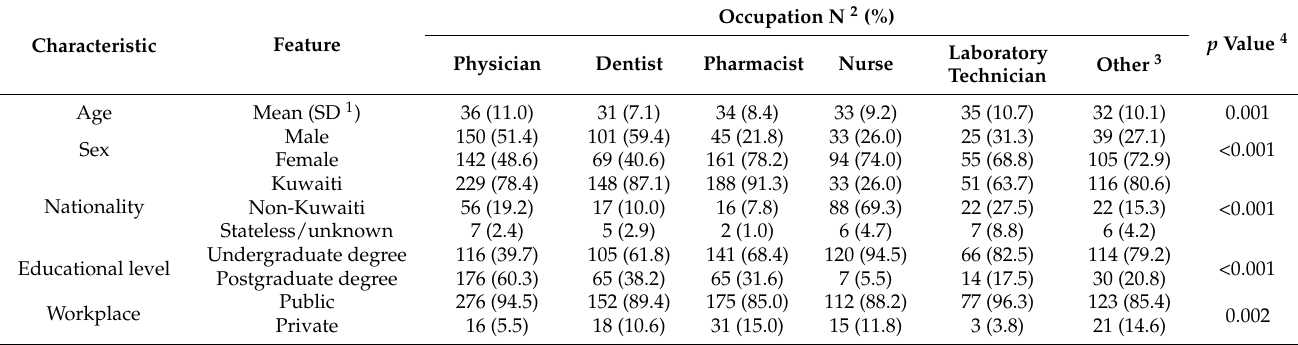
3.2. An Overall High Rate for Acceptance of COVID-19 Vaccination among HCWs in